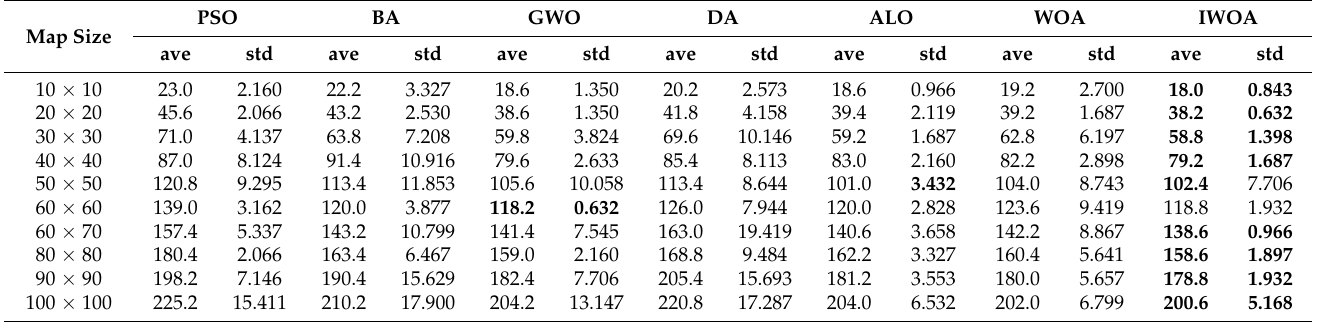
Table 4. Comparison of average value and standard deviation of different sized maps solved by different algorithms.